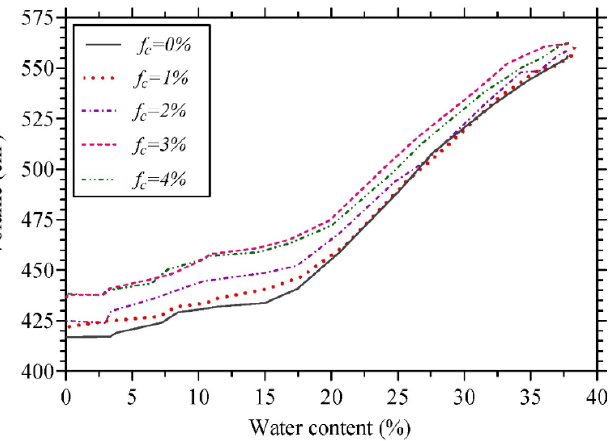
Figure 5. Volumetric shrinkage deformation as a function of water content for different WTTF con- tents [40].